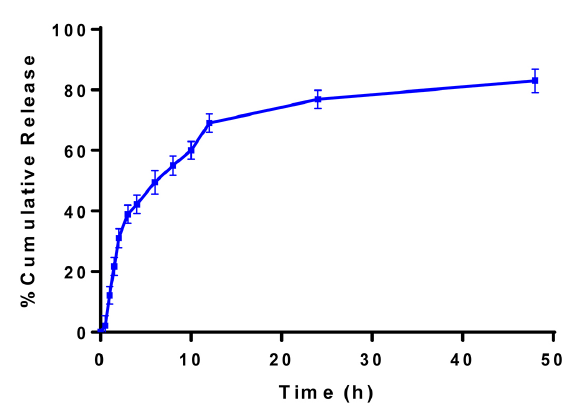
FIGURE 7 - Release rates of lenalidomide from PLGA-NPs in vitro in HCl buffer pH 1.2 (mean±SD, n = 3).